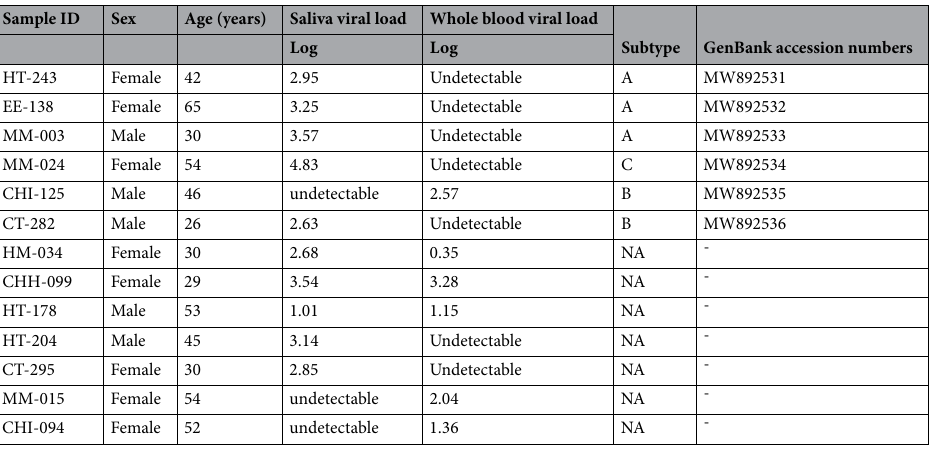
Table 2. Description of HHV-8 characteristics in patients with detectable viral load. NA: not amplifiable.